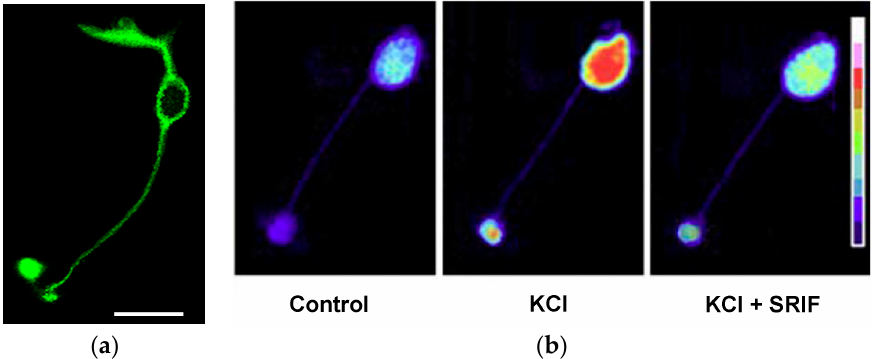
Figure 5. Modulation of Ca 2+ accumulation by somatostatin via SST 2A in isolated rod bipolar cells (RBCs). ( a ) RBCs express the somatostatin receptor SST 2A . Immunocytochemistry with antibody against the SST 2A protein in a mouse RBC. Scale bar: 10 µm. ( b ) Fluorescence, pseudocolor images of a rabbit RBC loaded with fluo-3 to monitor intracellular [Ca 2+ ] and observed by confocal laser microscopy. Application of 60 mM KCl to depolarize cell membrane KCl indicated an increase in [Ca 2+ ] as compared to its level recorded when the cell was bathed in physiological solution (control). In the presence of KCl, the addition of 200 nM somatostatin (KCl + SRIF) significantly reduced the intracellular level of [Ca 2+ ]. The fluorescence (right vertical bar) is an arbitrary 256-point grey scale converted to pseudocolor. Modified from ( a ) [116]; ( b ) [136].